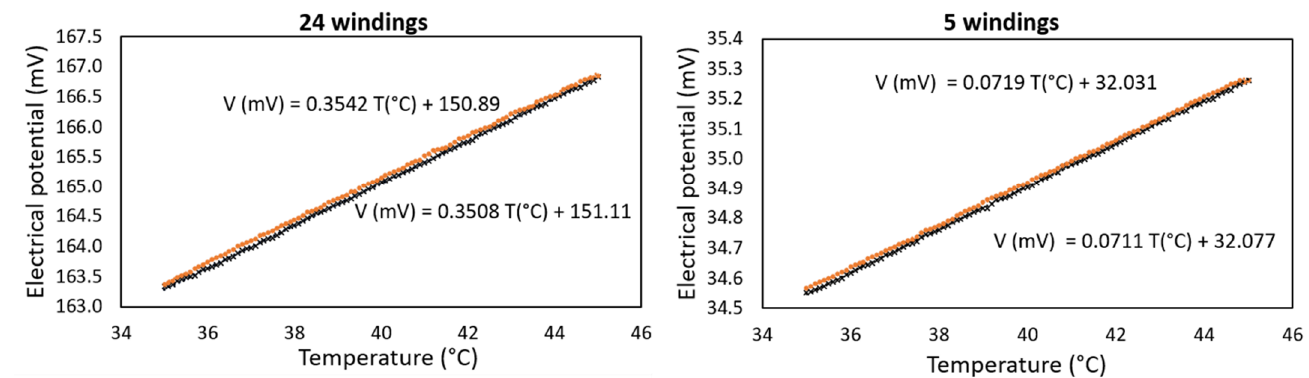
Figure 10. Experimental sensitivity of the sensors for the different fabricated RTDs according to the windings number. Orange line represents an increase temperature from 35 to 45 °C, and black line a decrease temperature from 45 to 35 °C.